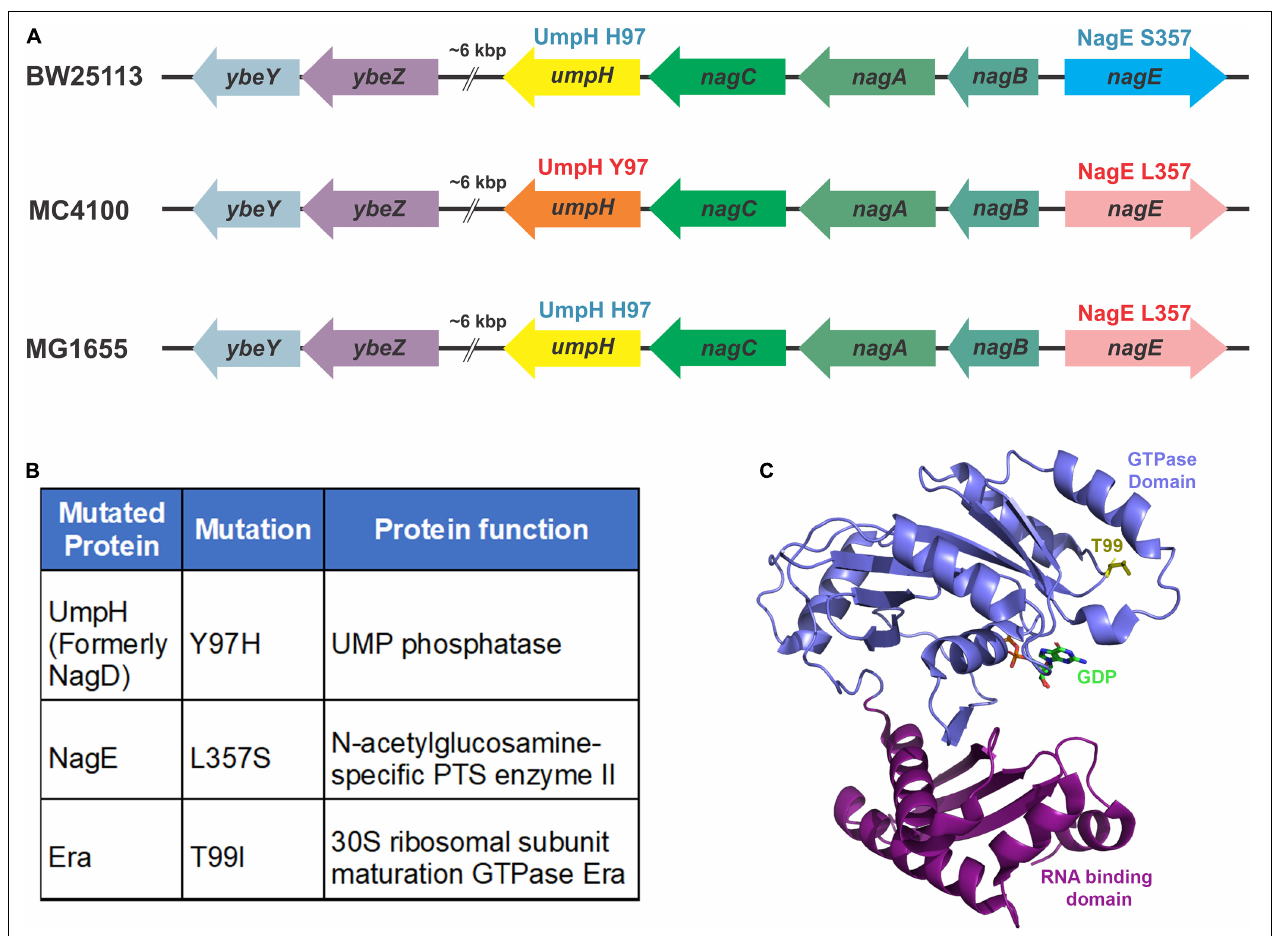
FIGURE 2 | Mutations identified by whole-genome sequencing. (A) The variations in the nagD and nagE alleles in commonly used wild-type strains are indicated. The BW25113 strain carries the alleles that express UmpH H97 variant (represented by the yellow arrow) and NagE S357 variant (blue arrow). The MC4100 strain carries the alleles that express UmpH Y97 variant (orange arrow) and NagE L357 variant (pink arrow). The MG1655 strain carries the alleles that express UmpH H97 variant (yellow arrow) and NagE L357 variant (pink arrow). (B) Allelic differences between ybeY( +) and (cid:49) ybeY(sup1) are indicated in the table as protein variants. (C) Location of the threonine 99 residue (yellow stick) in the GTPase domain (blue ribbon) indicated on the Era crystal structure (PDB: 3IEU). RNA binding domain is indicated as purple ribbon.